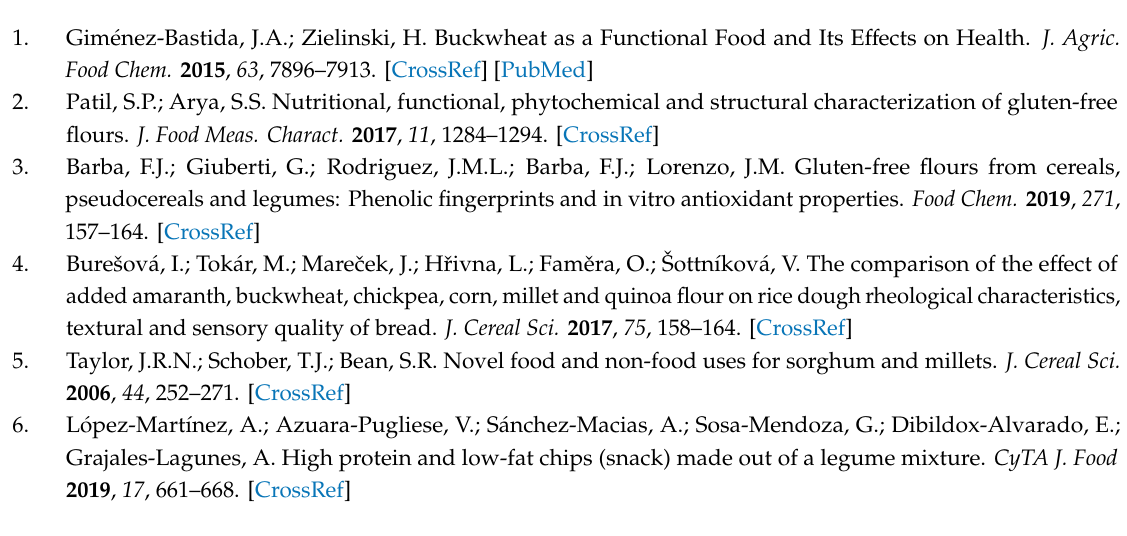
Table S1: Samples analysed in this work; Table S2: Information declared in the nutrition facts label of the samples analysed in this work; Table S3: Instrumental validation parameters of the HPLC / MS-MS separation; Table S4: Evaluation of the matrix e ff ect comparing the spiked sample (0.1 mg / kg) with a standard solution of atropine and scopolamine with the same concentration *; Table S5: Recovery, intraday and interday repeatability of the method calculated on a sorghum flour sample (So-FO) spiked with atropine and scopolamine; Table S6: Textural properties and functionalization degree of five di ff erent batches of prepared M-SBA-15-SO 3 − sorbent; Table S7: RASFF notifications of the last five years (2015-2020) on atropine and scopolamine in cereal and bakery products; Figure S1: XRD patterns of: (a) SBA-15; (b) L-SBA-15-SO 3 − , (c) M-SBA-15-SO 3 − and (d) H-SBA-15-SO 3 − ; Figure S2: Pore size distribution of: (a) SBA-15, (b) L-SBA-15-SO 3 − , (c) M-SBA-15-SO 3 − and (d) H-SBA-15-SO 3 −